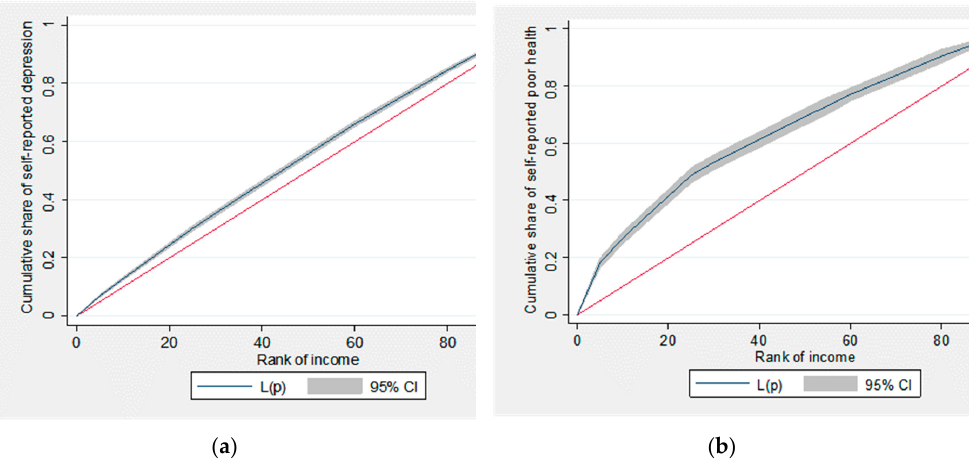
Figure 1. Concentration curves for self-reported depression and poor SRH. ( a ) Concentration curve for self-reported depression; and ( b ) concentration curve for poor SRH. Abbreviations: SRH, self-rated health.